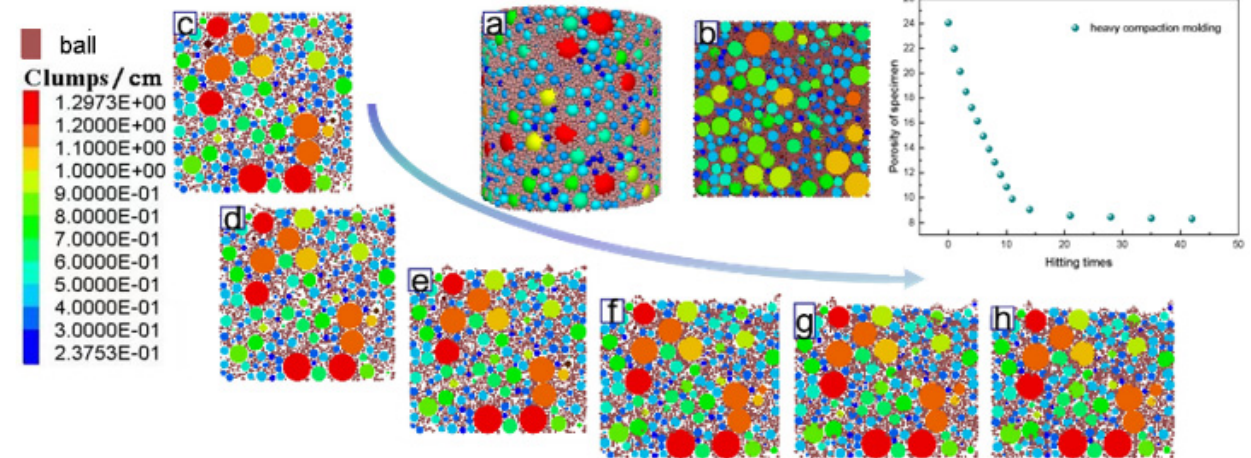
Figure 5. Changes in porosity during compaction molding. ( a ) is the specimen model used for compaction molding in this paper; ( b ) is the axial section of the specimen model; ( c ) is the axial section of the specimen before compaction; ( d ) is the axial section of the specimen after 1 compaction; ( e ) is the axial section of the specimen after 5 compaction; ( f ) is the axial section of the specimen after 10 compaction; ( g ) is the axial section of the specimen after 17compaction; ( h ) is the axial section of the specimen after compaction is completed. In the figure, E is abbreviation for exponent, for example, the number 2.3753E-1 stands for 0.23753.